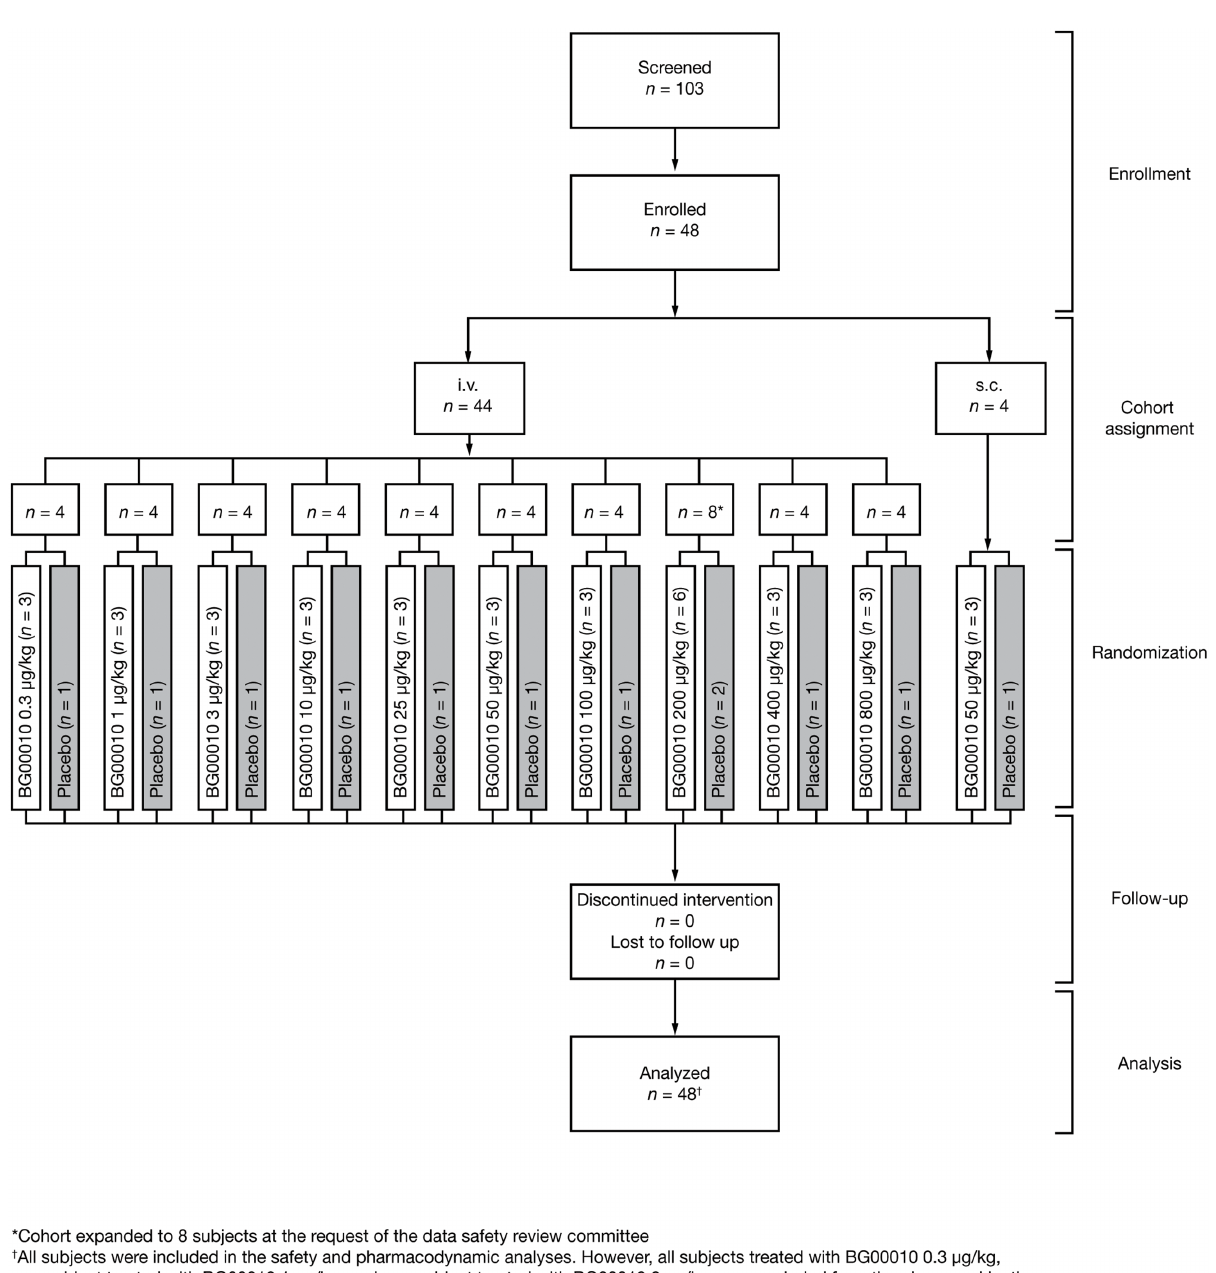
Fig 1. Subject disposition. i.v., intravenous; s.c., subcutaneous.